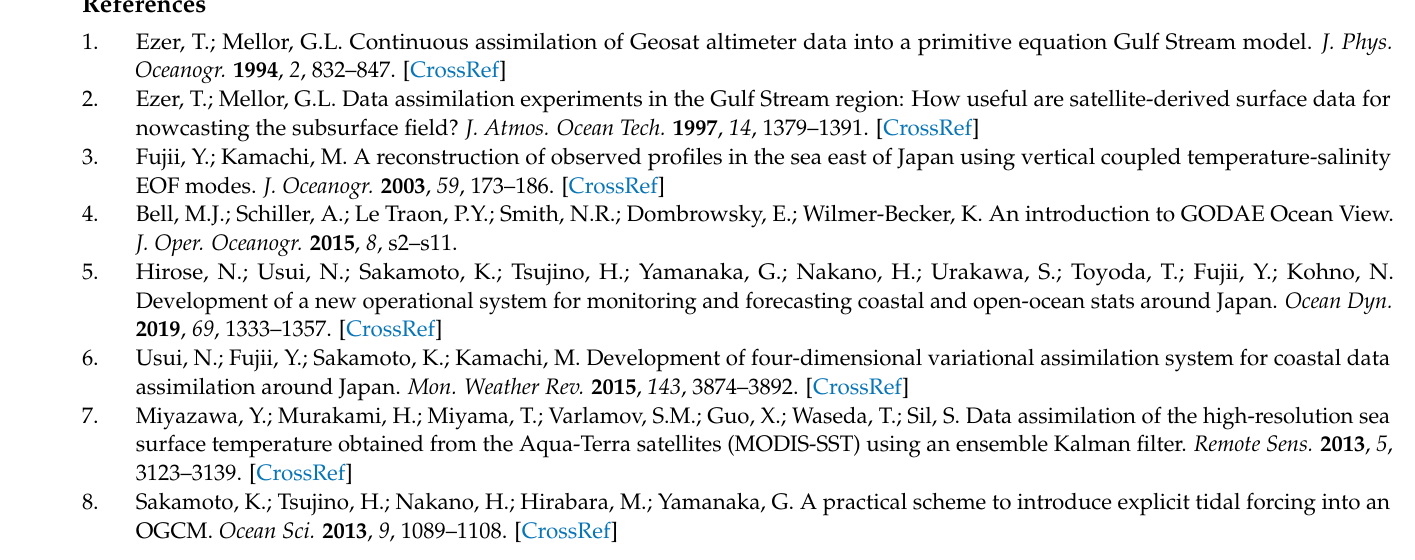
The previous version of JCOPE-T uses a simpler formula (the spectral nudging scheme [9]) as: ∂ T ( t ) = Dynamics ( T ( t ))+ T R ( τ ) − (cid:101) T ( t ) , ∆ t ∂ t n ( τ ≤ t ≤ τ + 1), Equation (A8), where T R ( τ )( S R ( τ )) is not the DA analysis but the daily mean outputs for the period [ τ : τ + 1] from the model JCOPE2M as the “reference” data; (cid:101) T ( t )( (cid:101) S ( t )) denote the 3-day running mean of the model temperature/salinity variables; ∆ t n denotes a time scale of 5 days. JCOPE2M assimilates the SSHA, Himawari-8 SST, MGDSST, and TS data with a 4-day interval for obtaining the analysis temperature/salinity and the IAU algorithm with the analysis temperature/salinity was applied to the model with a 4-day period [12]. In the present study, we analyzed the products of this version (the “NUDGE” case) based on the indirect DA approach for